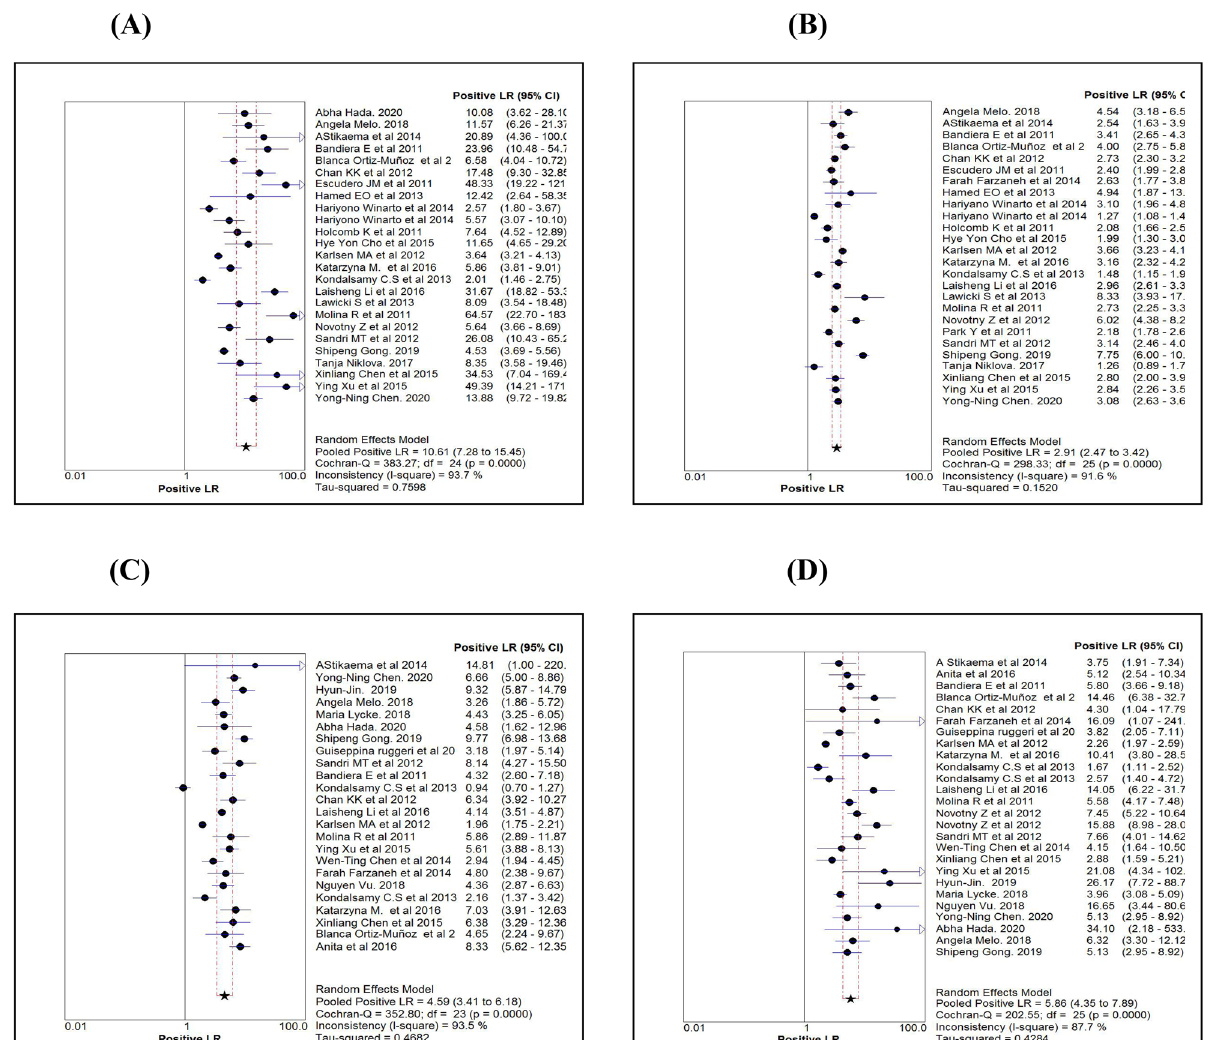
Figure 5. Comparison of positive likelihood ratio estimates (using Random effect model) of HE4 ( A ), CA125 ( B ), ROMA for pre-menopause ( C ) and ROMA for post-menopause ( D